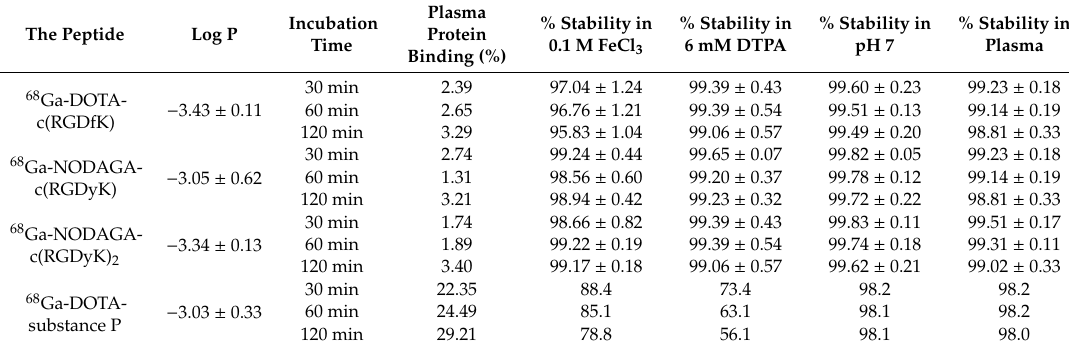
Table 1. In vitro characterization of tested peptides. Partition coe ffi cient (log P), human plasma protein binding and in vitro stability of 68 Ga-peptides under various conditions presented as the mean of radiochemical purity ± standard deviation (n = 3 and n = 1 for 68 Ga-DOTA-substance P) at di ff erent time points.